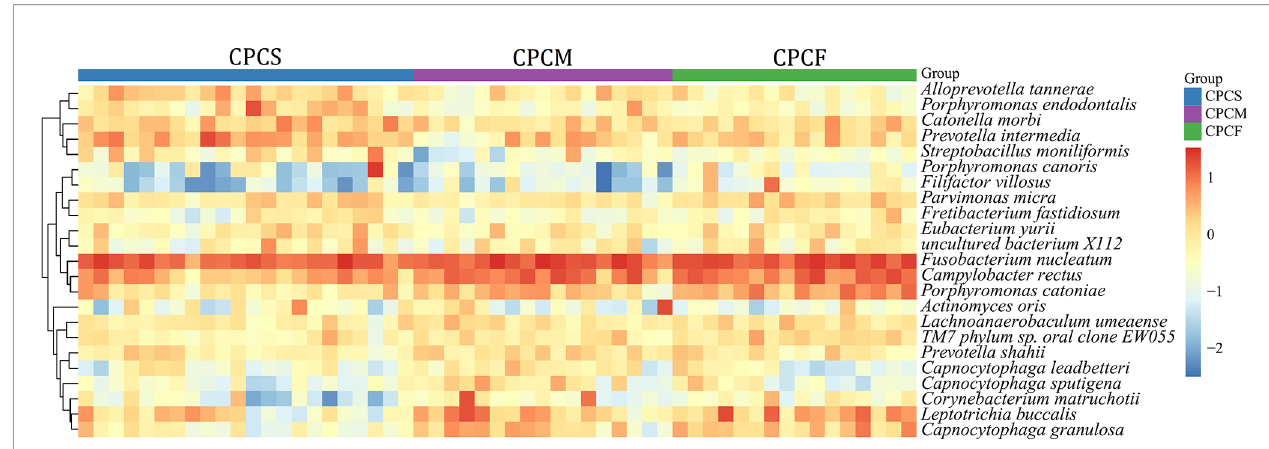
FIGURE 5 | Relative abundance of species in supragingival plaque microbiota of CPCS, CPCM, and CPCF. Different colors re fl ect relative abundance from low (blue) to high (red). CPCS, CP children with severe or extremely severe caries; CPCM, CP children with mild-to-moderate caries; CPCF, CP children without